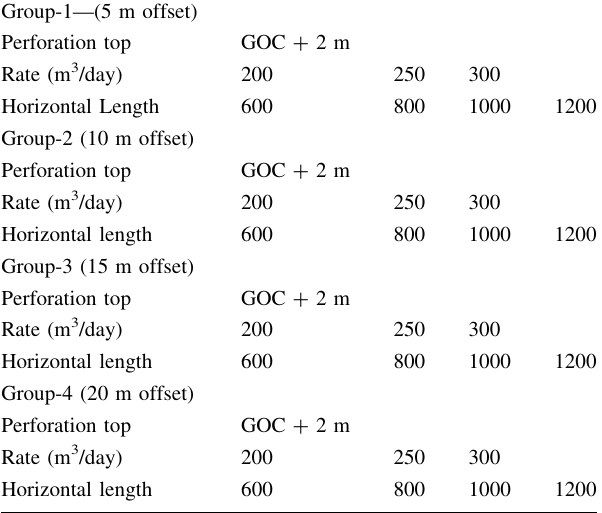
Table 4 Sensitivity parameters for Group-1 through